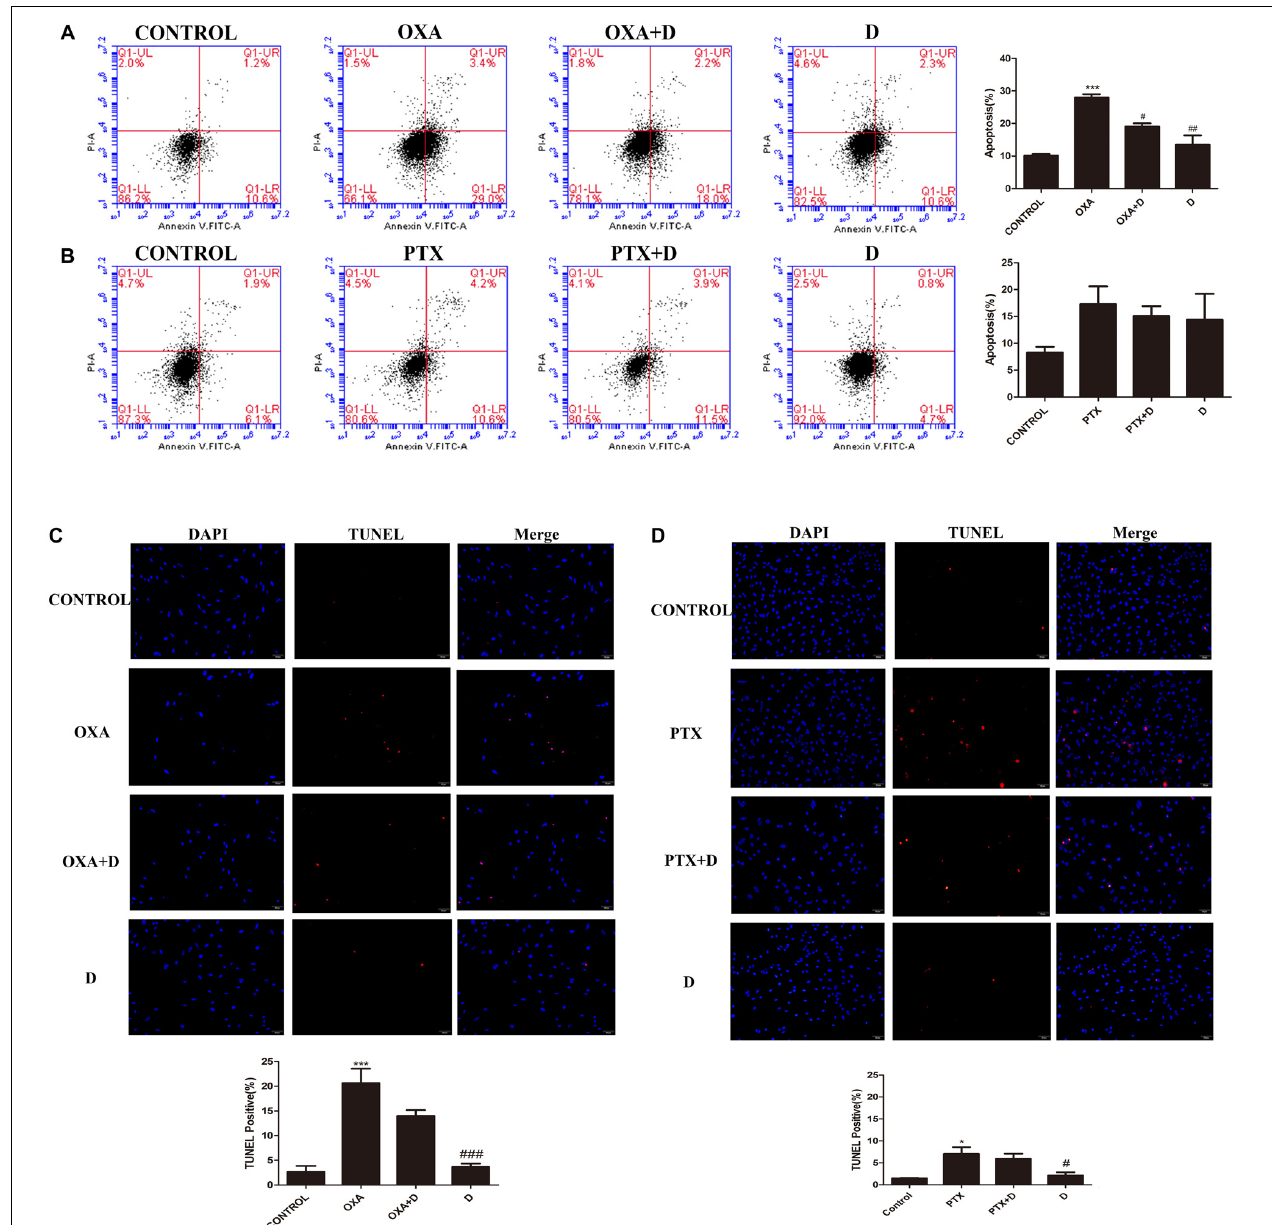
FIGURE 2 | Effect of duloxetine on DRG neuronal apoptosis through flow cytometry and TUNEL assay. After growing in culture for 24 h, DRG neuronal cells were exposed to OXA (3 µ M) with (or without) duloxetine (3 µ M) for another 48 h (A,C) or exposed to PTX (300 nM) with (or without) duloxetine (300 nM) for another 24